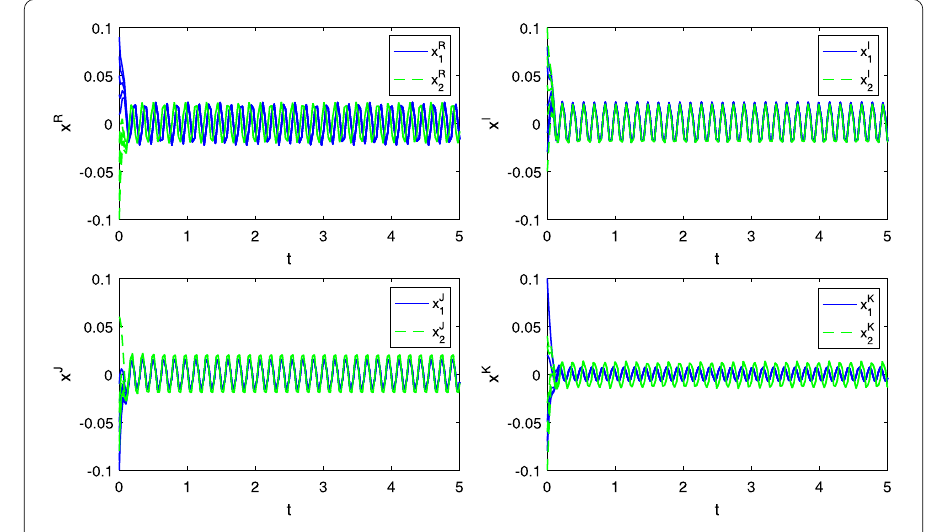
Figure 1 The states of four parts of x 1 and x